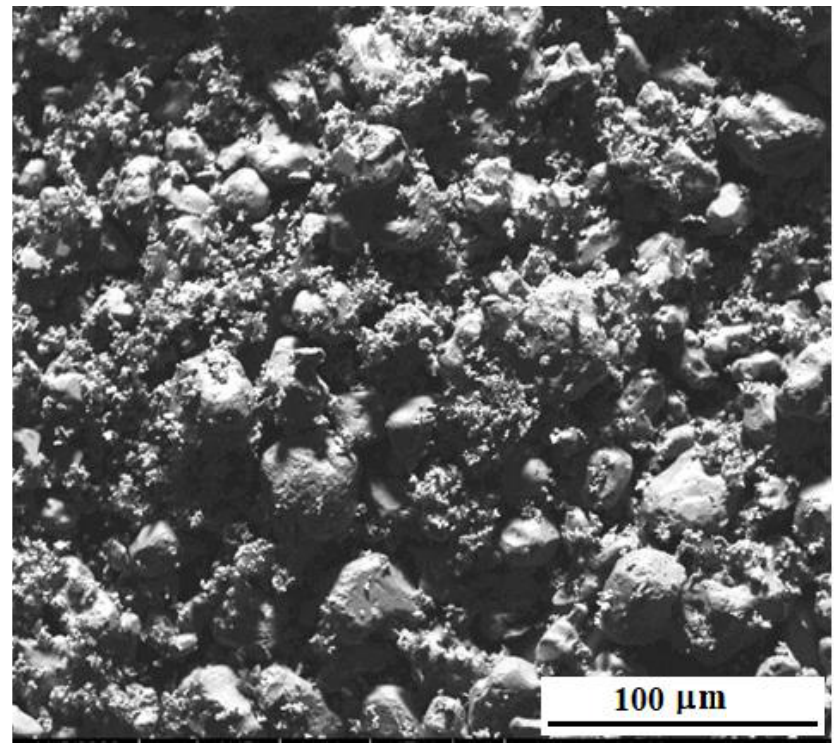
Figure 2. Microstructure of “M” powders after mixing in a ball mill.